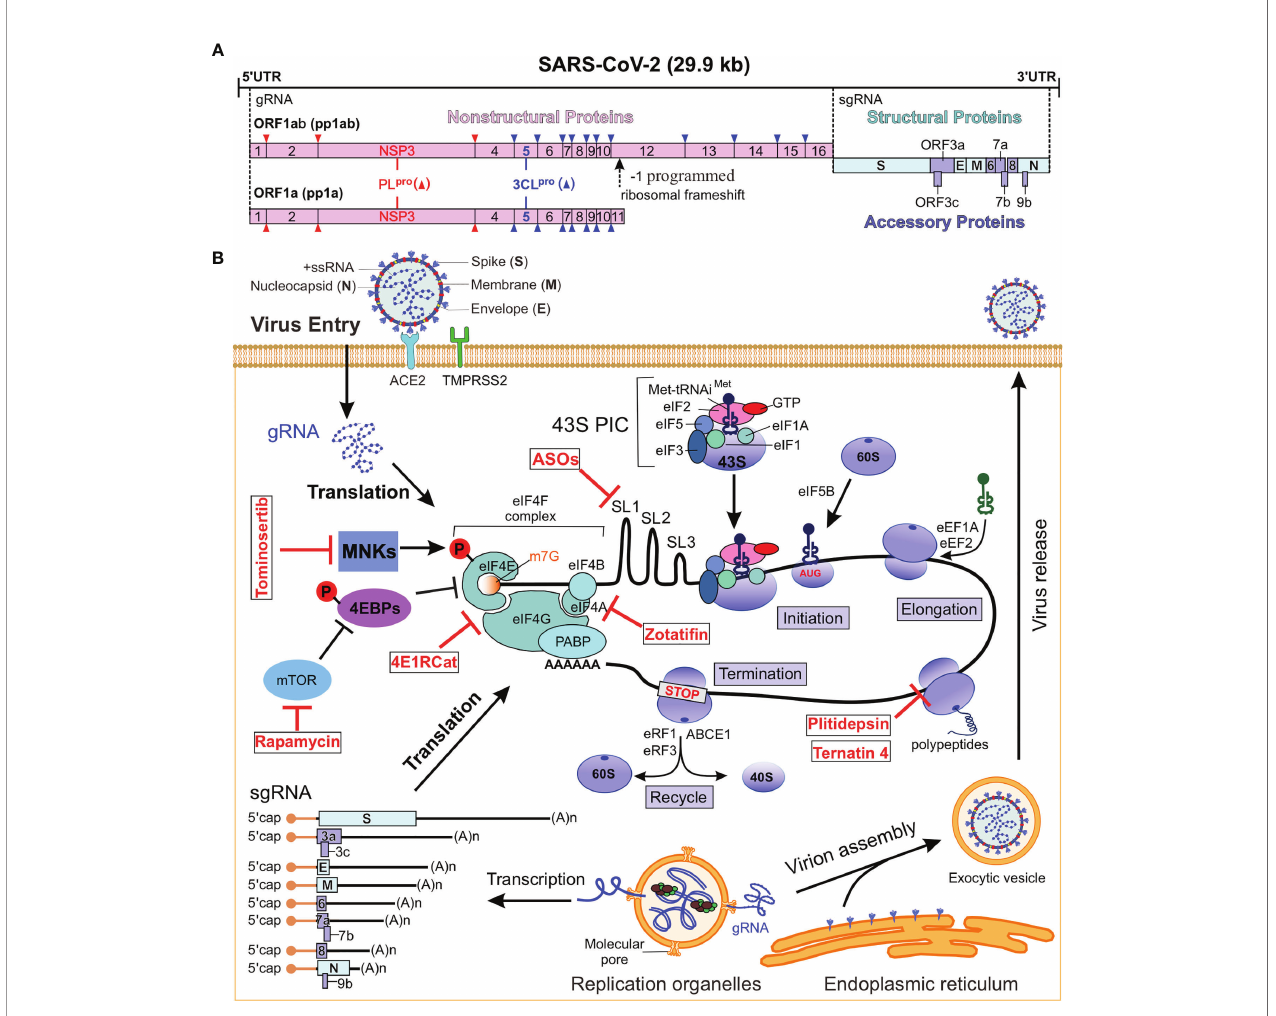
FIGURE 1 | SARS-CoV-2 genome and replication cycle. (A) Genome organization of SARS-CoV-2. The single-stranded RNA genome encodes for NSPs, structural proteins and accessory proteins. The sense RNA genome serves as a template for the translation of pp1a and pp1ab, which are cleaved into 16 NSPs. The remaining 30% of the viral genome code at the 3 ’ end for structural and paraproteins. (B) SARS-CoV-2 replication cycle. b SARS-CoV-2 genome and replication cycle. The virus enters the host cell by binding to the ACE2 receptor and releases its genome into the host cytoplasm, whereupon viral proteins are translated by the host ribosome. New virions are assembled and released to complete the life cycle. The red parts are the localization sites of translation inhibitors that can be used for antiviral drugs ( Table 1 ). NSPs, nonstructural proteins; ACE2, receptor angiotensin converting enzyme 2; ORF, open reading frame; 43S PIC, 43S pre-initiation complex; MNKs, MAPK-interacting kinases; MAPK, mitogen activated protein kinase; 4EBP, eIF4E binding protein; mTOR, mechanistic target of rapamycin; PABP, poly (A) binding protein; ABCE1, ATP binding cassette subfamily E1; eIFs, eukaryotic initiation factor; eRFs, eukaryotic release factors; eEF1A, eukaryotic elongation factor 1A; Xrn1, 5 ’ -3 ’ exoribonuclease 1; gRNA, genomic RNA; sgRNA, subgenomic RNAs; ASOs, antisense